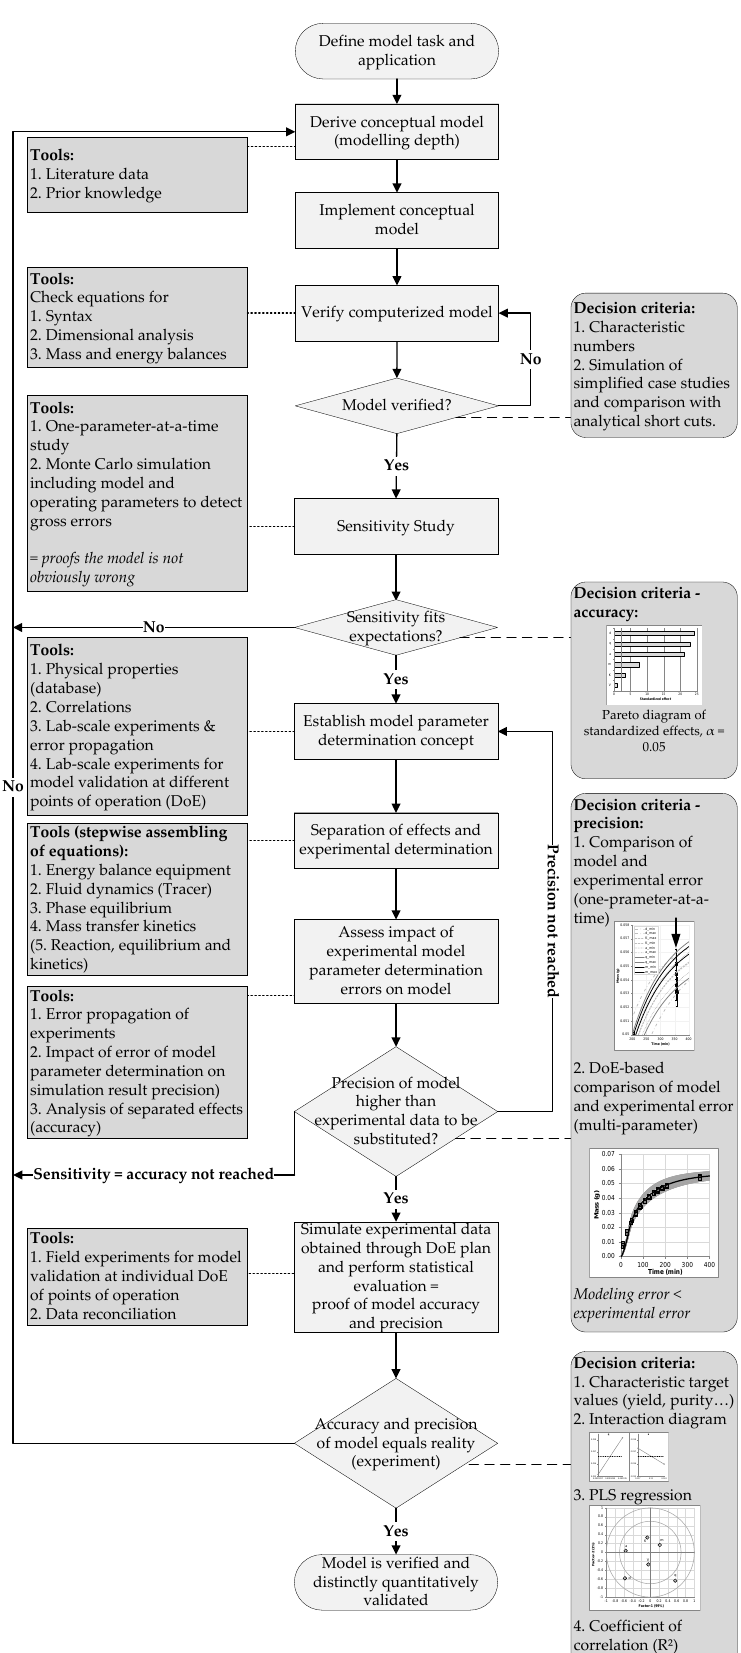
Figure 14. Workflow of process modelling and